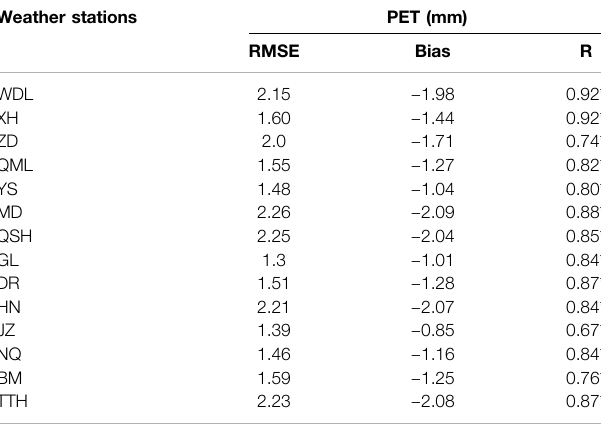
TABLE 1 | RMSE, bias and correlation coef fi cient (r) of PET between calculated monthly averaged value and GLDAS simulations in the TRH region. Weather stations PET